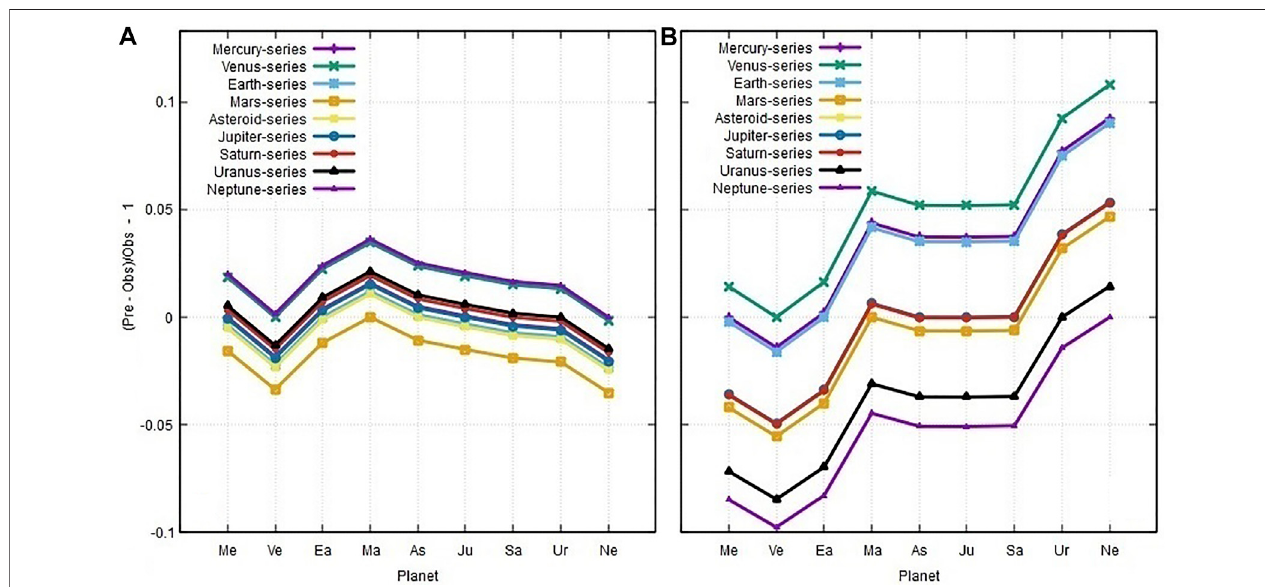
FIGURE 6 | Relative errors regarding the predictions of the semi-major axis lengths of the planets of the solar system according to: (A) the Geddes – King-Hele 12- TET based model ( Eq. 13 ) herein proposed; (B) the harmonic orbit resonance model by Aschwanden (2018) ( Eq. 21 ).